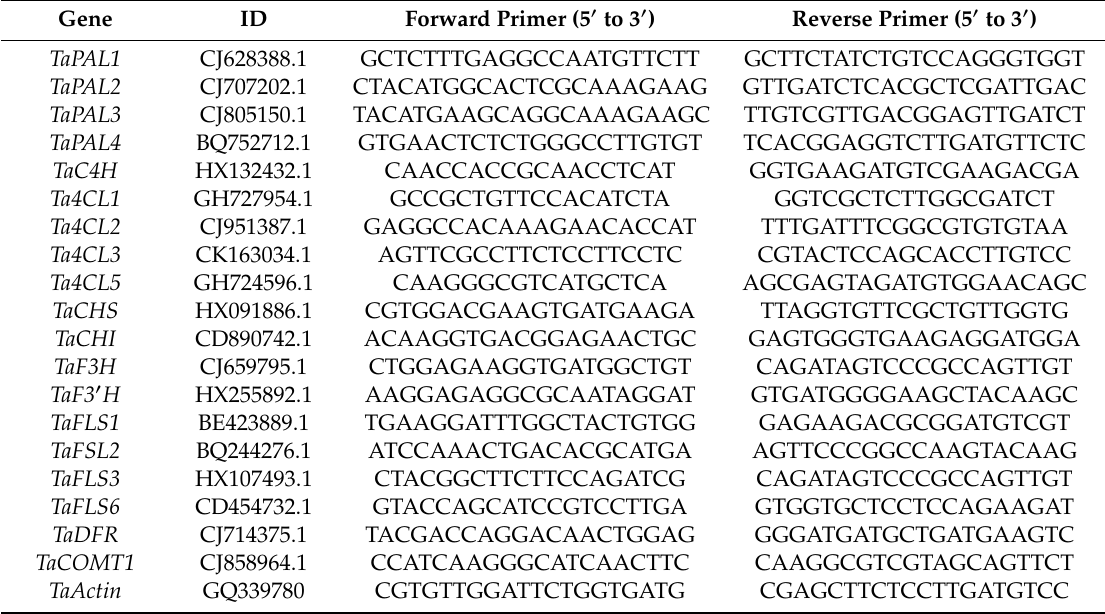
Table 1. Primers used in this study for quantitative real-time PCR analysis. Gene ID Forward Primer (5 (cid:48) to 3 (cid:48) ) Reverse Primer (5 (cid:48) to 3 (cid:48)